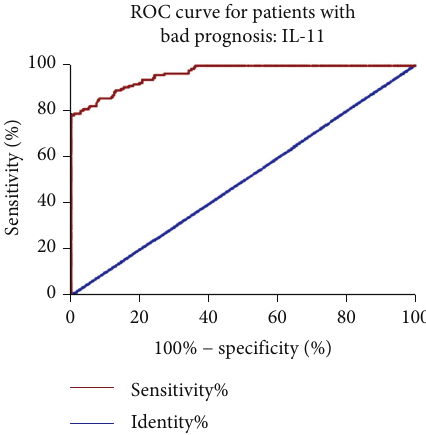
Figure 3: ROC curves for IL-11 in diagnostic poor prognosis of ischemic stroke